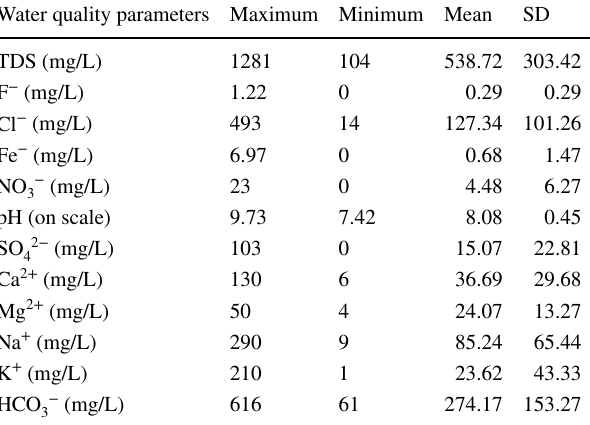
Table 4 Descriptive statistics of the groundwater quality